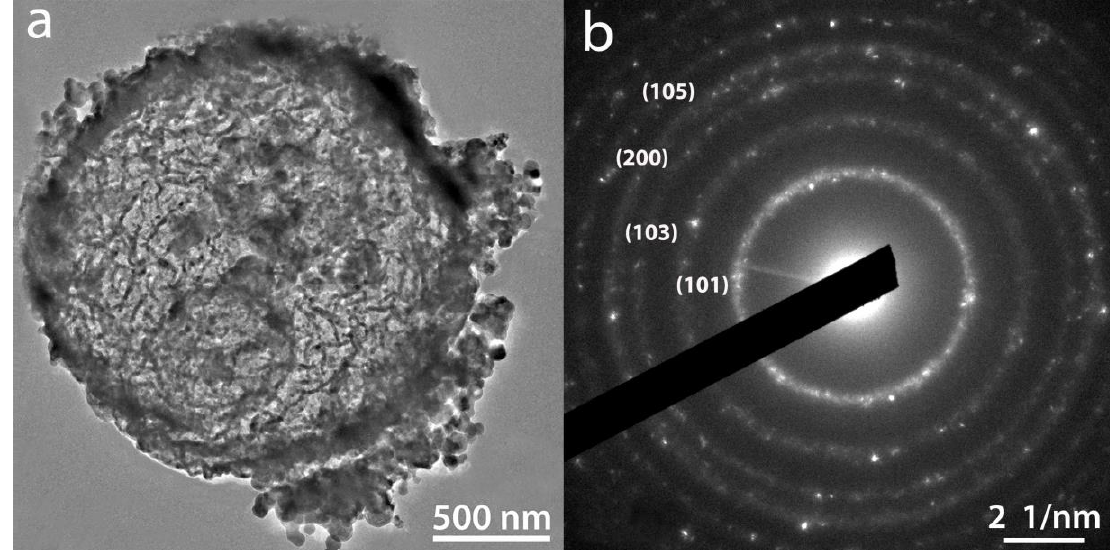
Figure 5. TEM picture of a 0.12%_550 HS where the shell thickness of the capsule can be observed ( a ). SAED pattern corresponding to the HS is shown in ( b ).